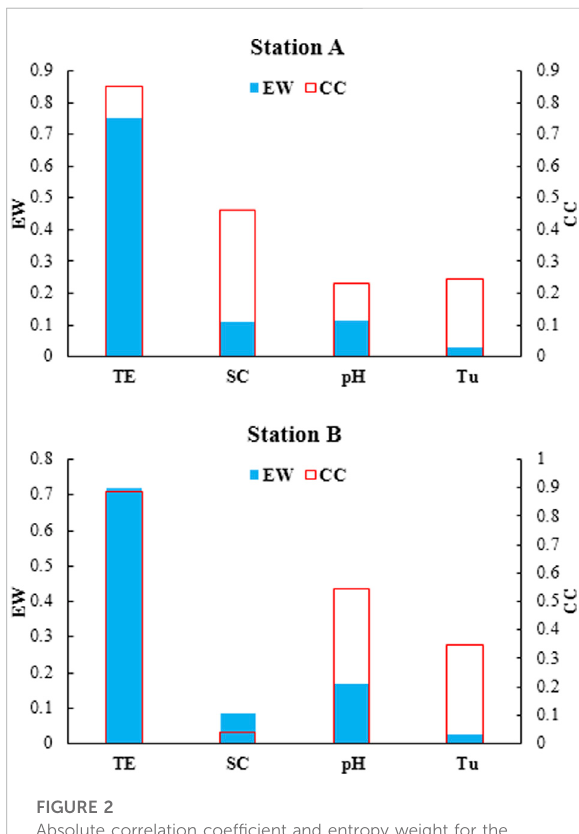
FIGURE 2 Absolute correlation coef fi cient and entropy weight for the input variables at Station-A and